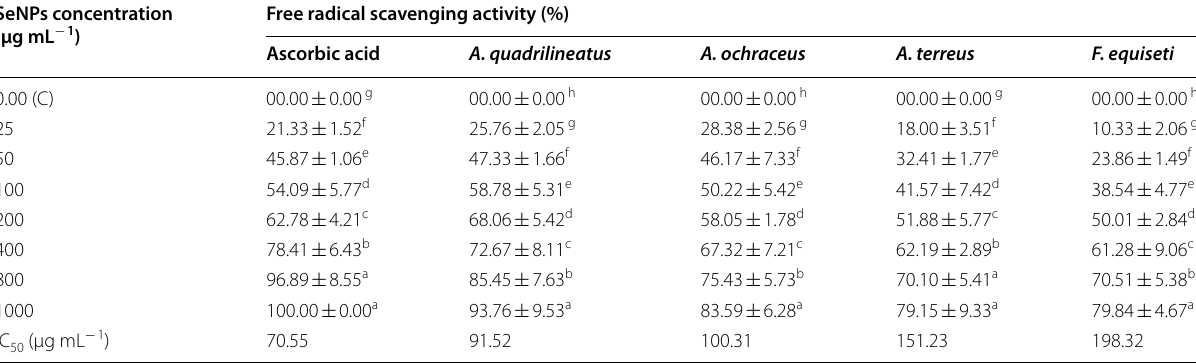
DPPH scavenging assay was used for measuring the antioxidant activities of the synthesized nanoparticles at 517 nm using DPPH solution under the conditions described in Materials and Methods. Calculated mean is for triplicate measurements from three independent experiments in the same column are considered statistically different (LSD test, P